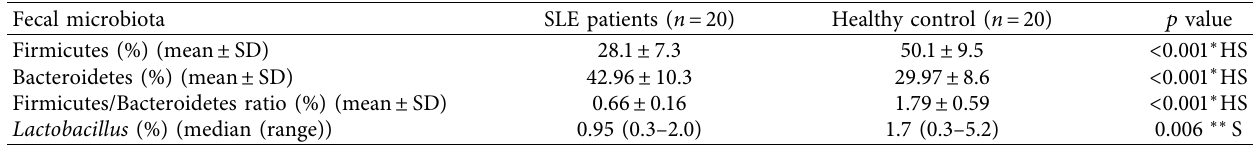
Table 3: The mean (or median) ratio of target fecal microbiota in SLE patients and healthy subjects. Fecal microbiota